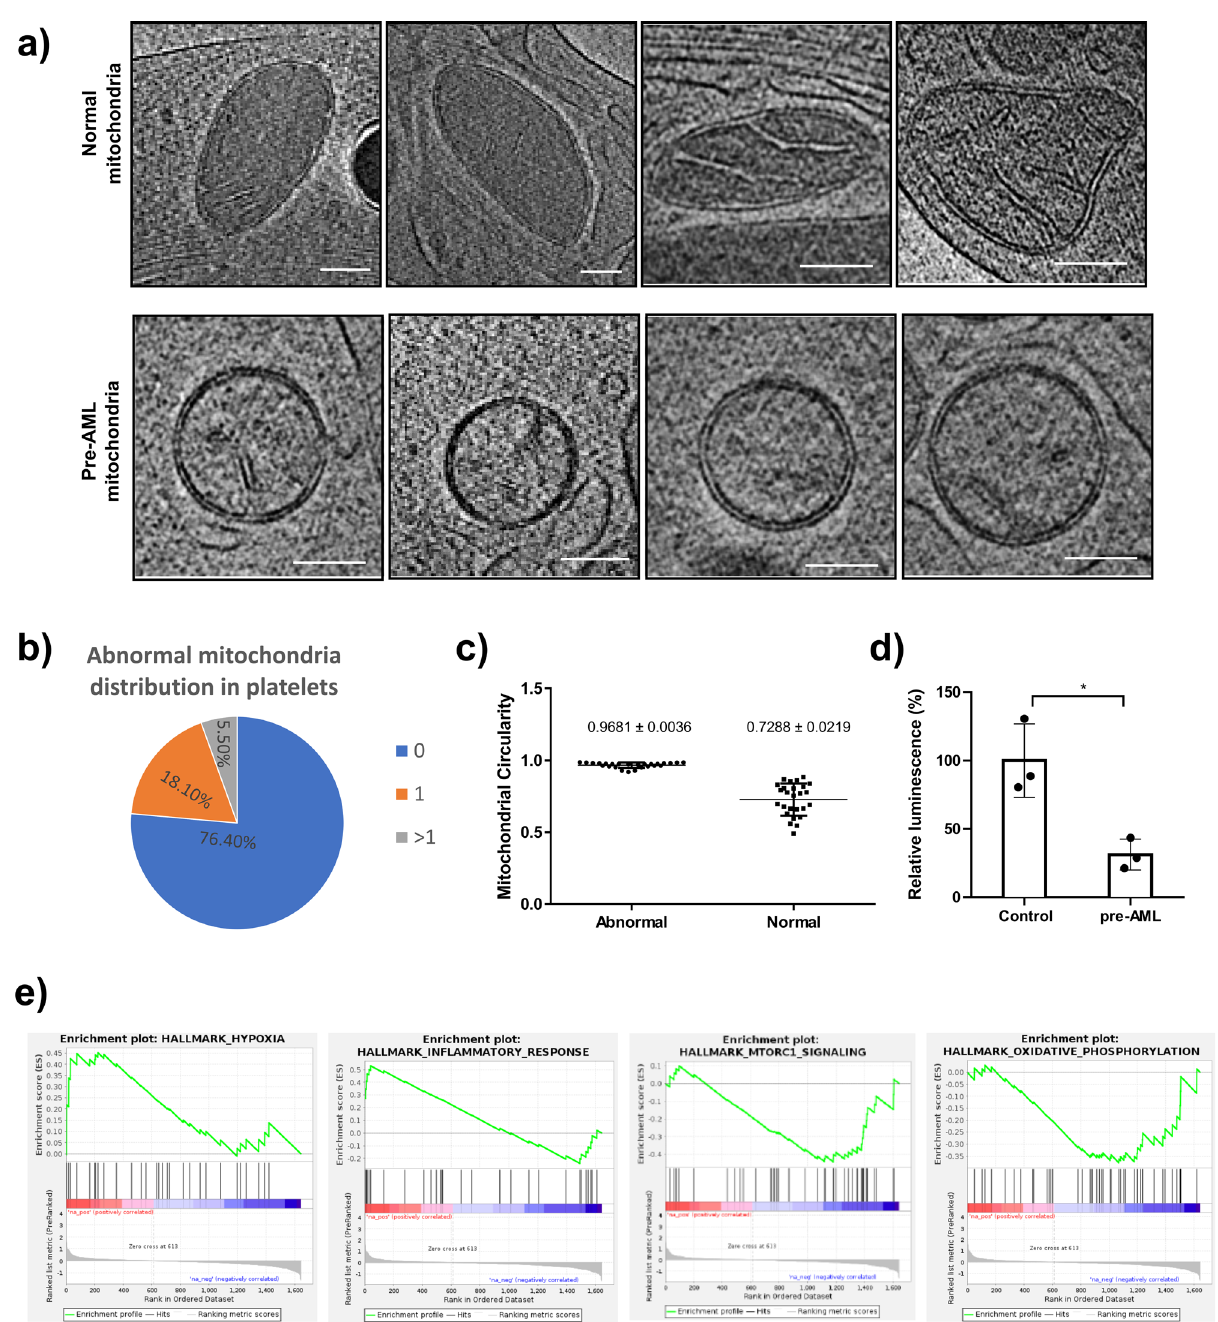
Fig. 3 Abnormal mitochondria in pre-AML platelets. a Roughly a quarter of mitochondria in pre-AML platelets were abnormal with reduced cristae and matrix (scale bar 100 nm). b 18.1% of the pre-AML platelets had one abnormal mitochondrion and 5.5% have more than one abnormal mitochondrion. c The statistical analysis of mitochondrial circularity ( P < 0.0001) d ATP measurement assay for mitochondria in control and pre-AML platelets. e Gene set enrichment analysis (GSEA) on the platelets from pre-AML and control mice. “ HYPOXIA ” and “ INFLAMMATORY_RESPONSE ” were up-regulated and “ MTORC1_SIGNALING ” and “ OXIDATIVE_PHOSPHORYLATION ” were down-regulated in pre-AML platelets, compared with control platelets. Data in ( c ) and ( d ) are presented as mean ± s.e.m. Student ’ s t test was used for statistical analyses. * P ≤